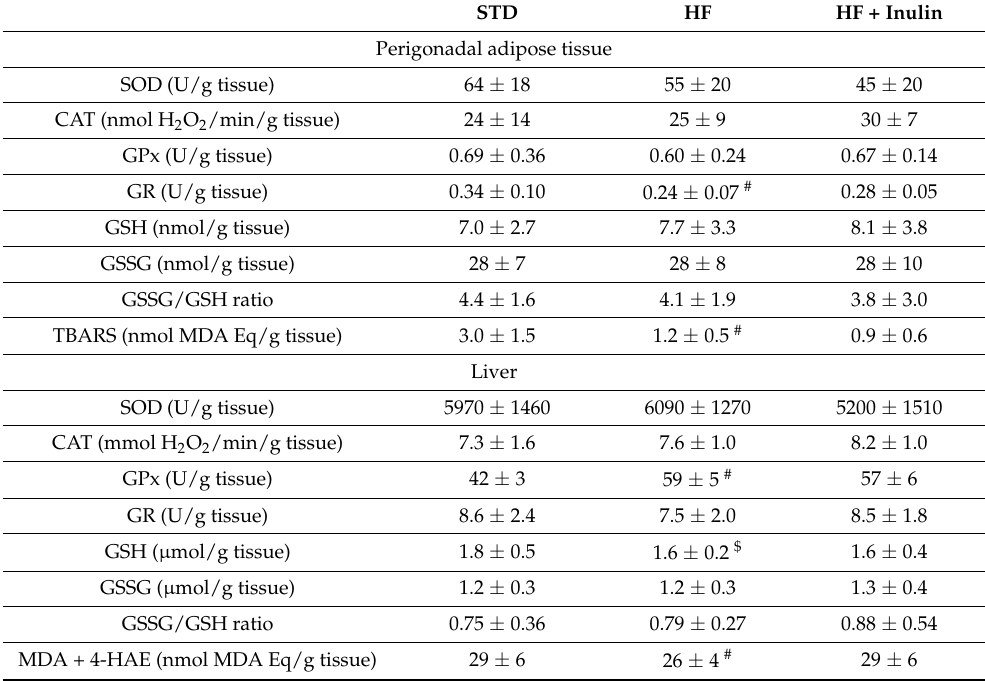
Table 4. Biomarkers of oxidative stress in tissues at the end of the